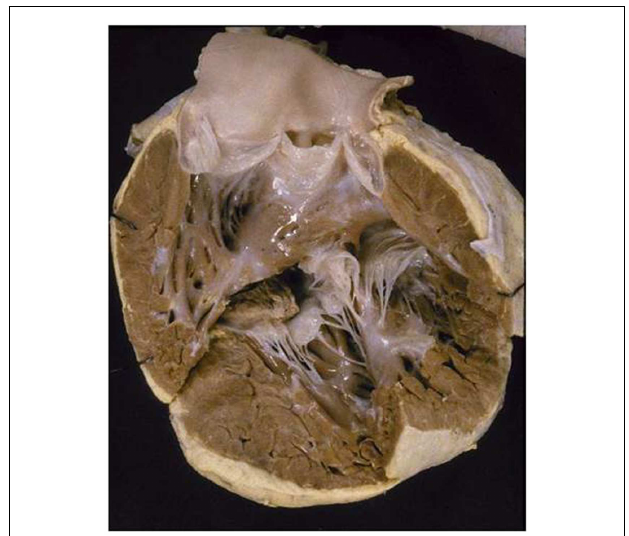
FIGURE 7 | Double inlet indeterminate ventricle . Both the atrioventricular valves drain into a ventricular chamber with coarse trabeculations of indeterminate morphology. A second separate ventricle was not